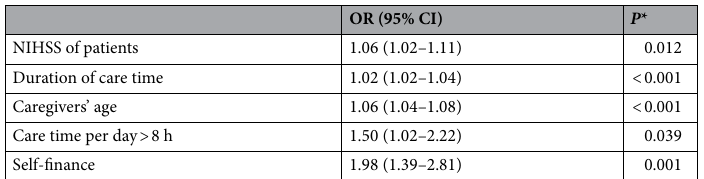
Table 4. Multivariable Models Showing Association Between baseline risk factors and depression. *Multivariable adjusted for caregiver’s age, NIHSS, duration of care time, sex, education, care time per day > 8 h, self-finance, relationship to the patients, household income.